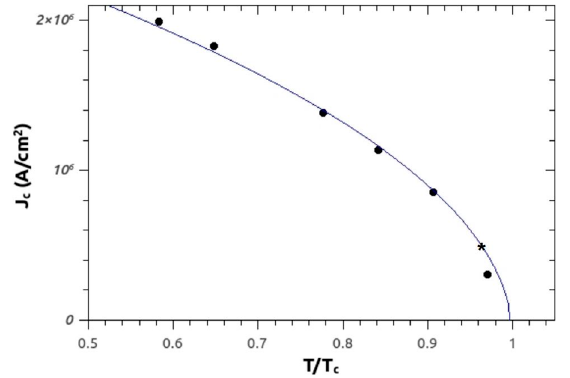
Figure 4. Critical current curve as a function of reduced temperature t for the Nb strip. Also shown (marked by a *) is one of the possible operating points close to T c , which may be chosen for the measurements. The continuous line is a fit using a (1 − t 2 ) 3/2 dependence (Adapted from [12], with the permission of IOP Publishing).